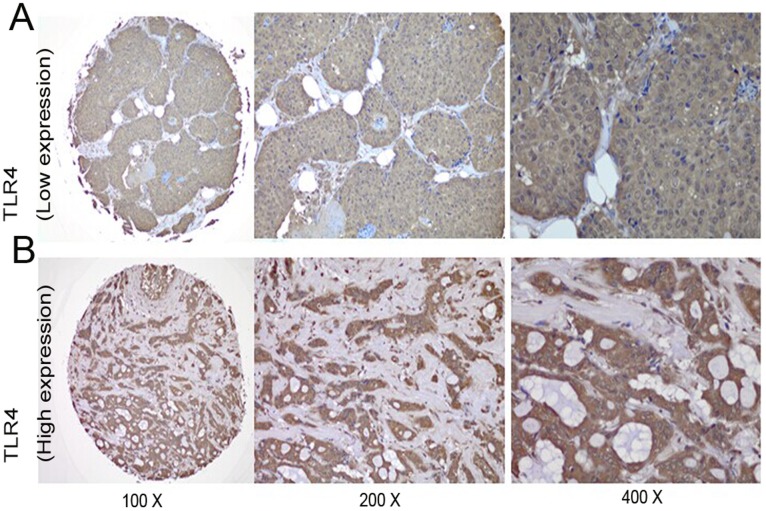
Representative TLR4 immunohistochemical staining in large (200× and 400× magnification) and small images (100× magnification).(A) Low immunostaining of TLR4 in invasive ductal breast carcinoma. (B) High immunostaining of TLR4 in invasive ductal breast carcinoma.